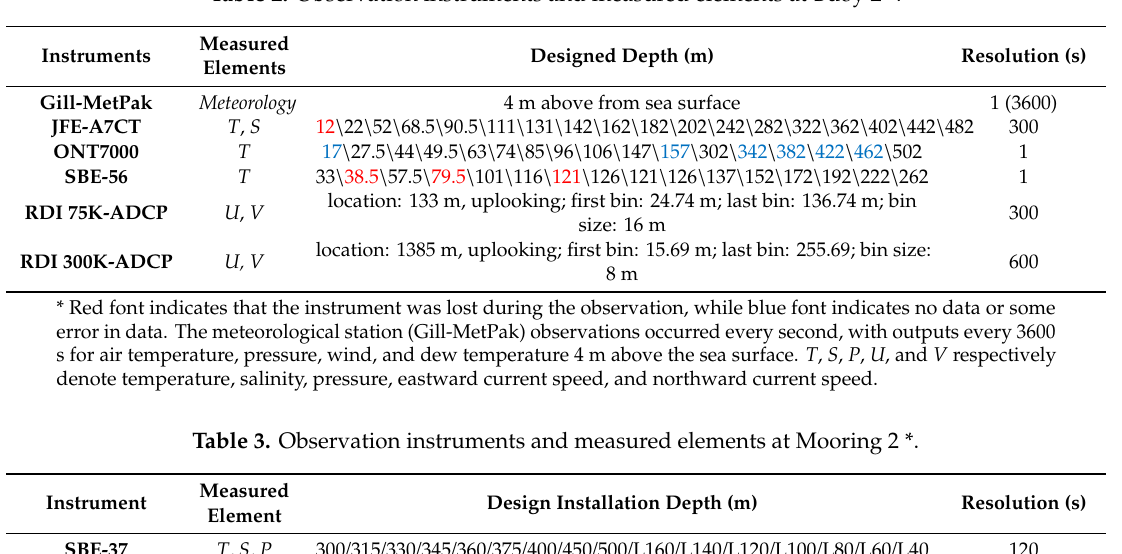
Table 2. Observation instruments and measured elements at Buoy 2 *.